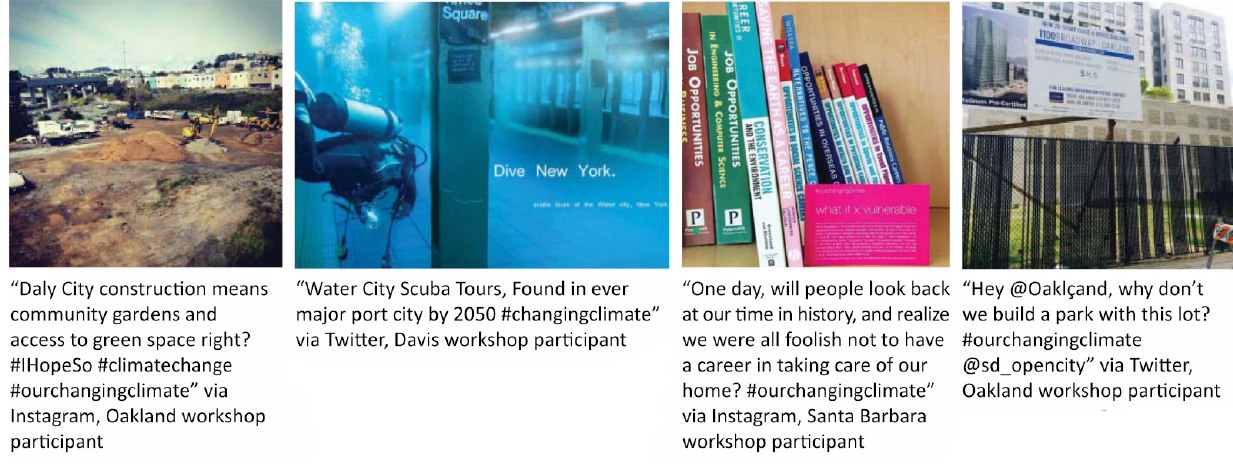
Figure 9. Speculative